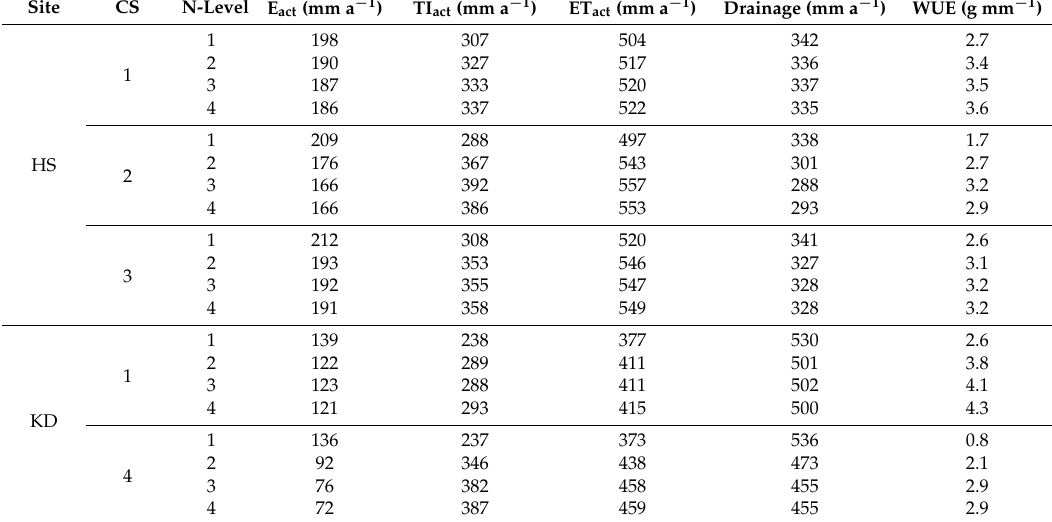
Table 8. Accumulated values of actual evaporation (E act ), transpiration including interception (TI act ), total evapotranspiration, drainage, and water use efficiency (WUE) calculated by simulation modelling for the different cropping systems (CS) on the two experimental sites under four different N supply levels.